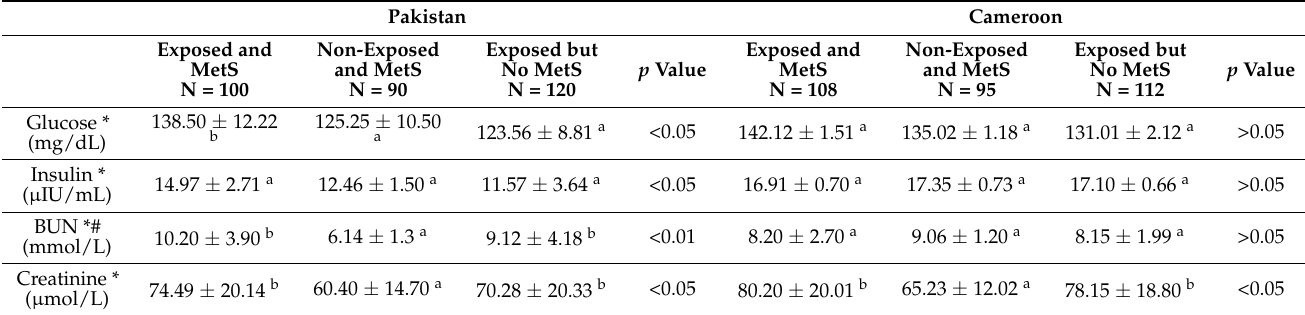
significant at p ≤ 0.05. # not significant in Cameroon group.